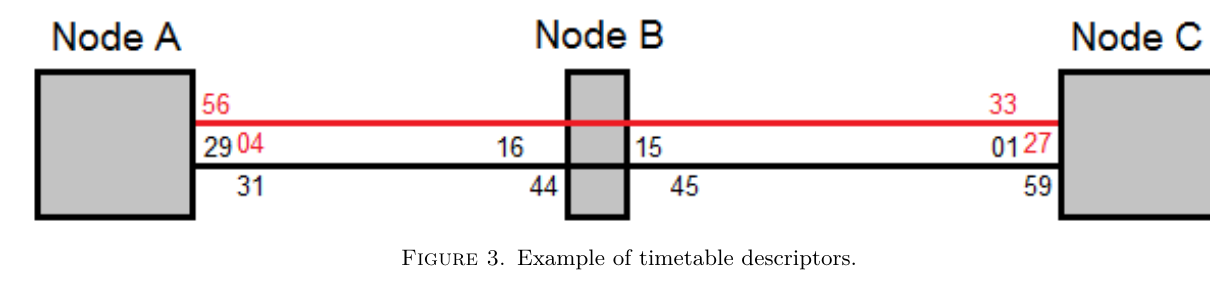
Figure 3. Example of timetable descriptors.